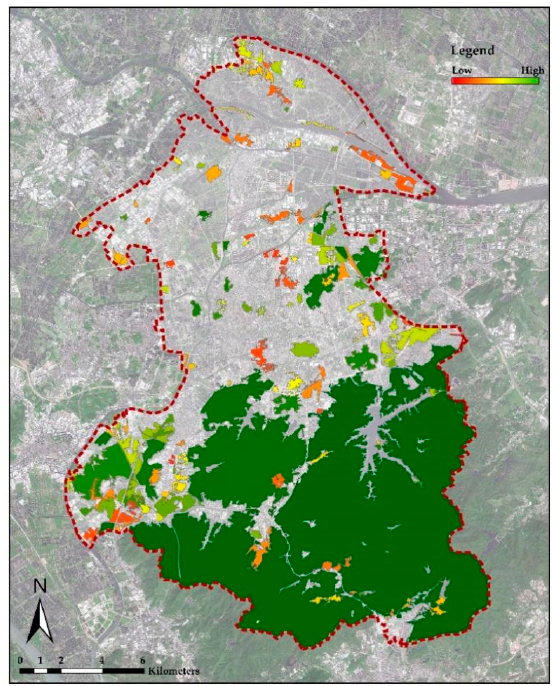
Figure 11. The ecological index of UGI.